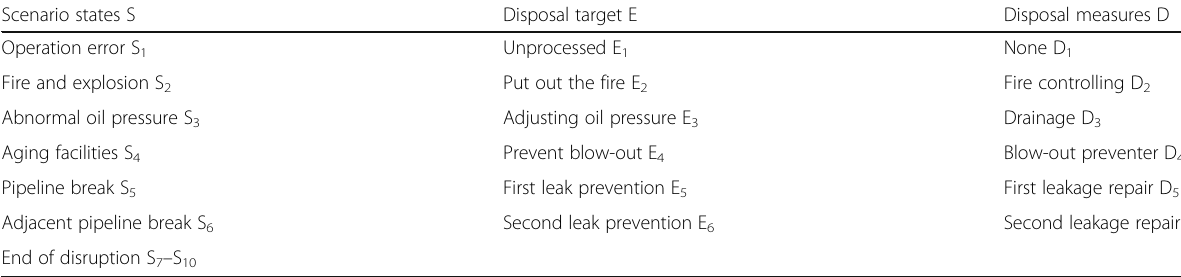
Table 2 Scenario elements of the Gulf of Mexico oil leakage